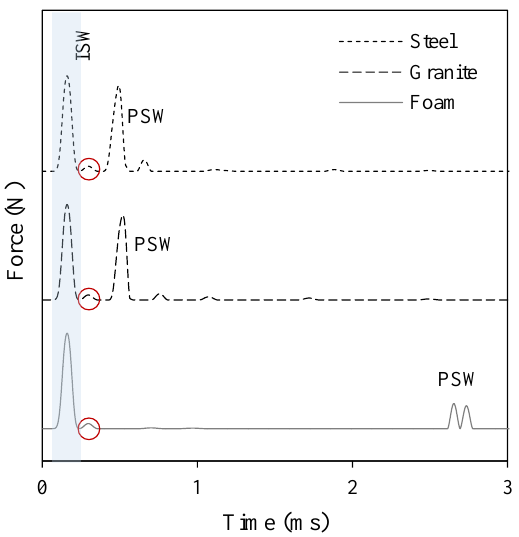
Figure 15. Solitary wave force profiles obtained from the numerical modeling of the interaction of